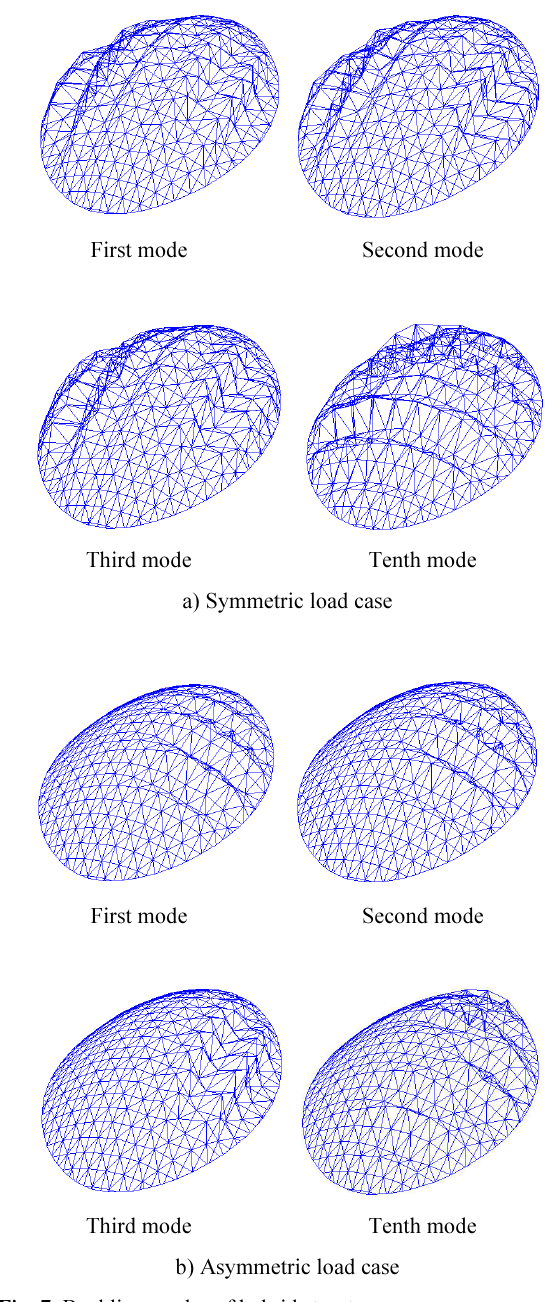
Fig. 7. Buckling modes of hybrid structure